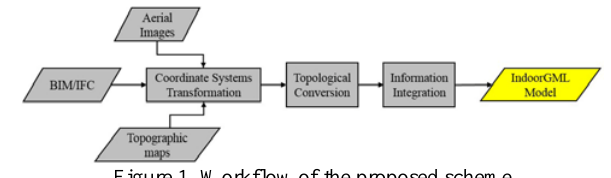
Figure 1. Workflow of the proposed scheme